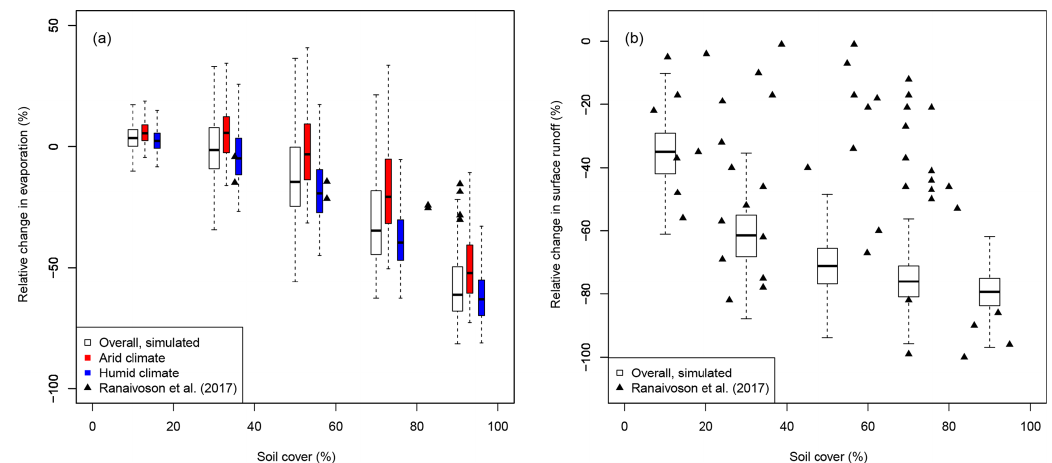
Figure 4. Relative change in evaporation (a) and surface runoff (b) relative to soil cover from surface residues for different soil cover values of 10%, 30%, 50%, 70%, and 90% (simulation NT_R_bs1 to NT_R_bs5 vs. NT_NR_bs, respectively). For better visibility, the red and blue boxplots are plotted next to the overall boxplots, but correspond to the soil cover value of the overall simulation (empty